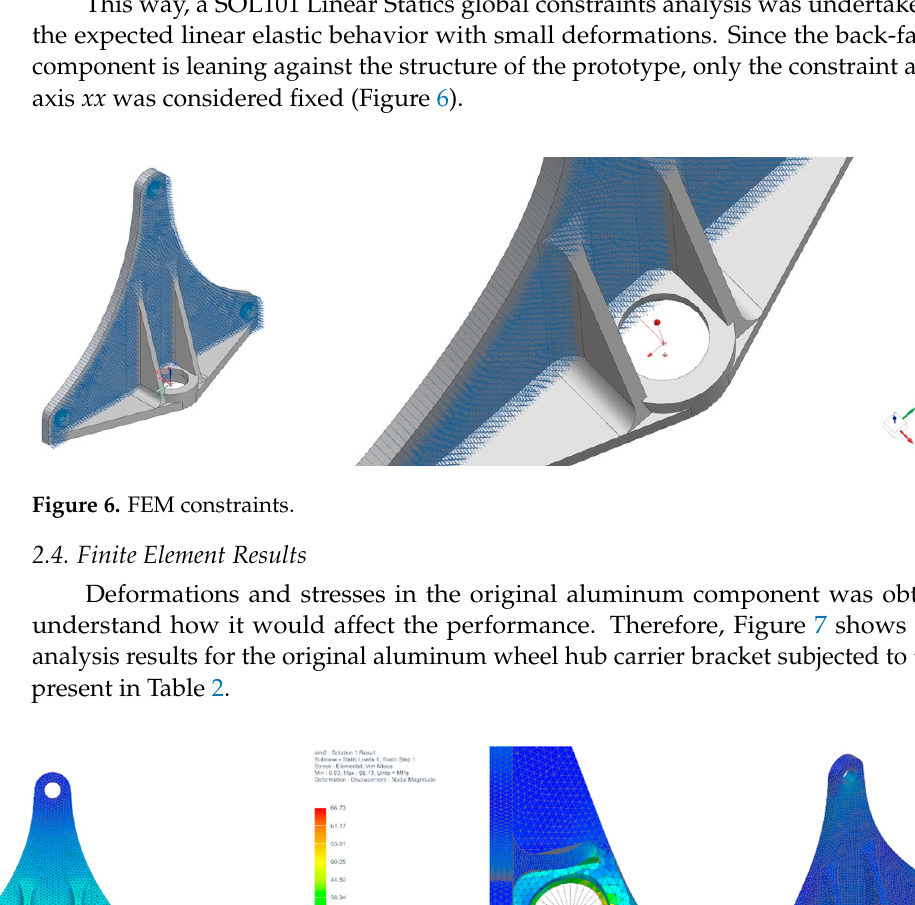
Figure 5. Finite element method (FEM) applied on the original aluminum wheel hub carrier bracket.